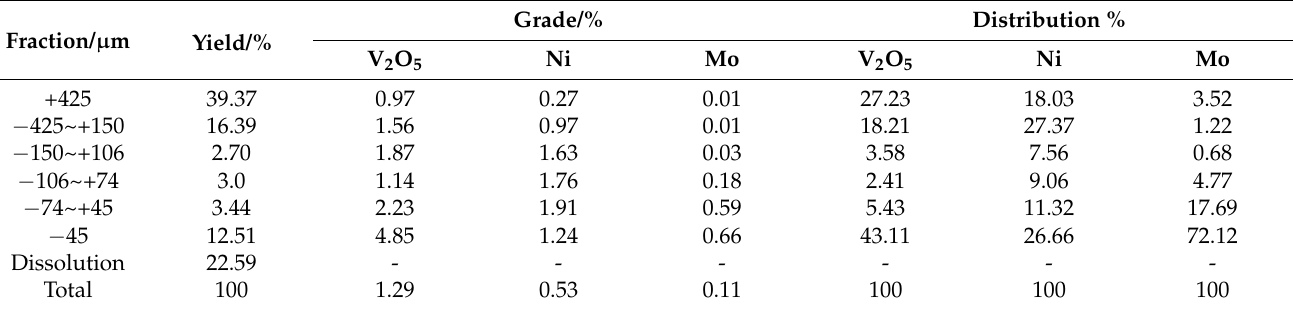
Table 3. Screening results for the raw ore.